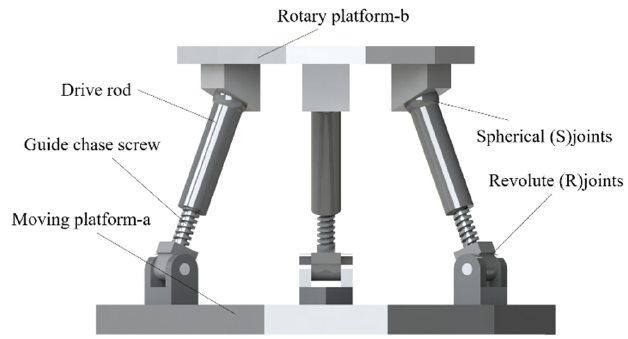
Figure 4. 3RPS rotary part.